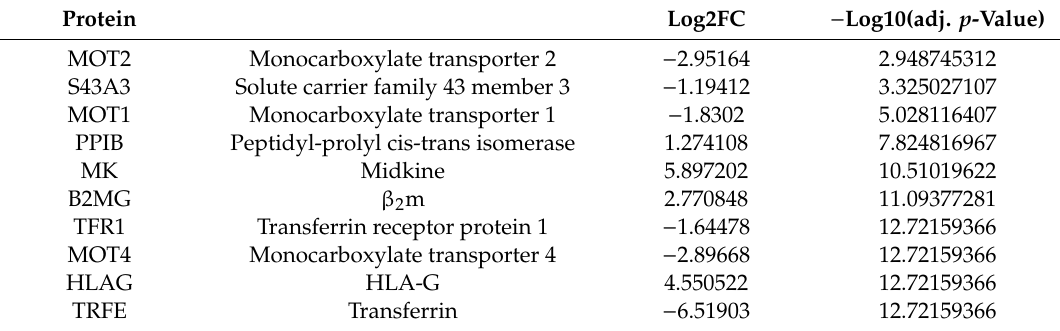
Table 2. Summary of statistical values of the identified receptor candidates and